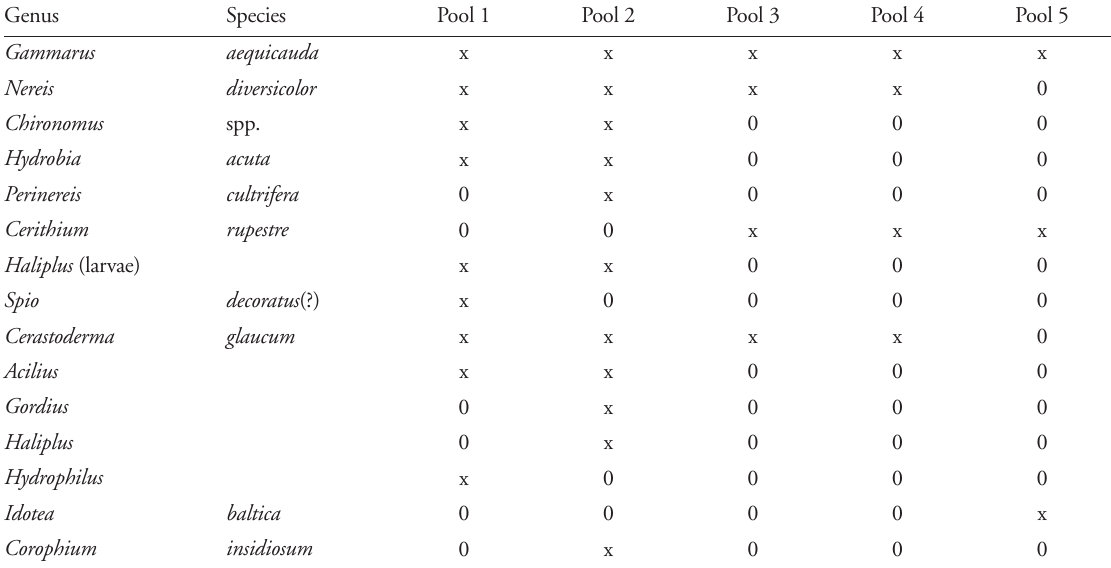
Table A1. List of sampled macroinvertebrates on Phragmites australis leaf detritus and incidence on the five sampling